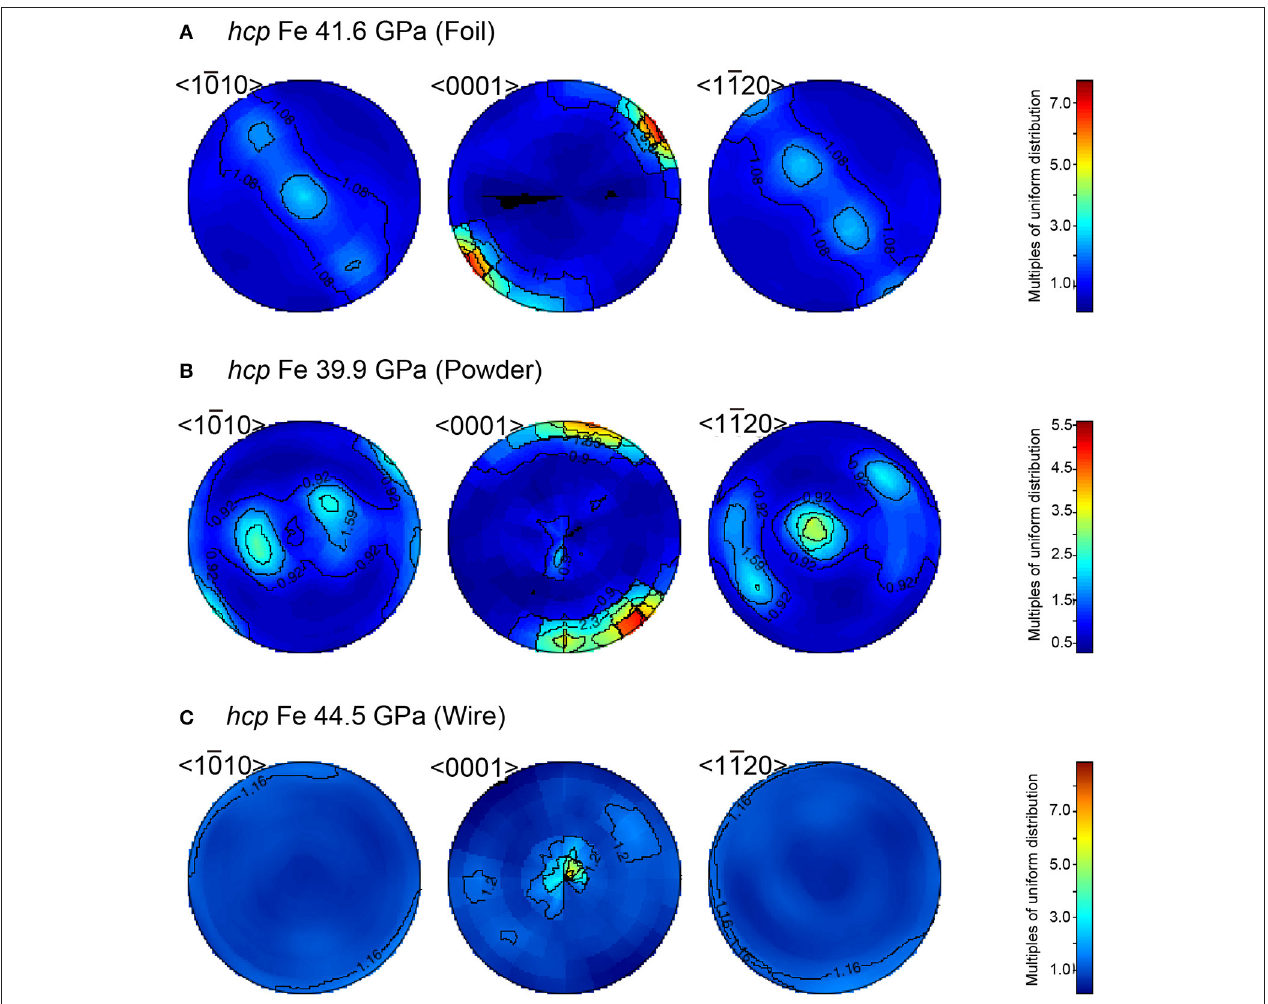
FIGURE 7 | Pole figures of hcp iron showing the variation in the crystallographic orientation of the < 10 ¯ 10 > , < 0001 > , and < 11 ¯ 20 > directions. (A) hcp iron at 41.6 GPa transformed from bcc iron foil. (B) hcp iron at 39.9 GPa synthesized from sintered powder sample. (C) hcp iron at 44.5 GPa that was made from bcc iron wire. The direction of a DAC compression is in the center of the pole